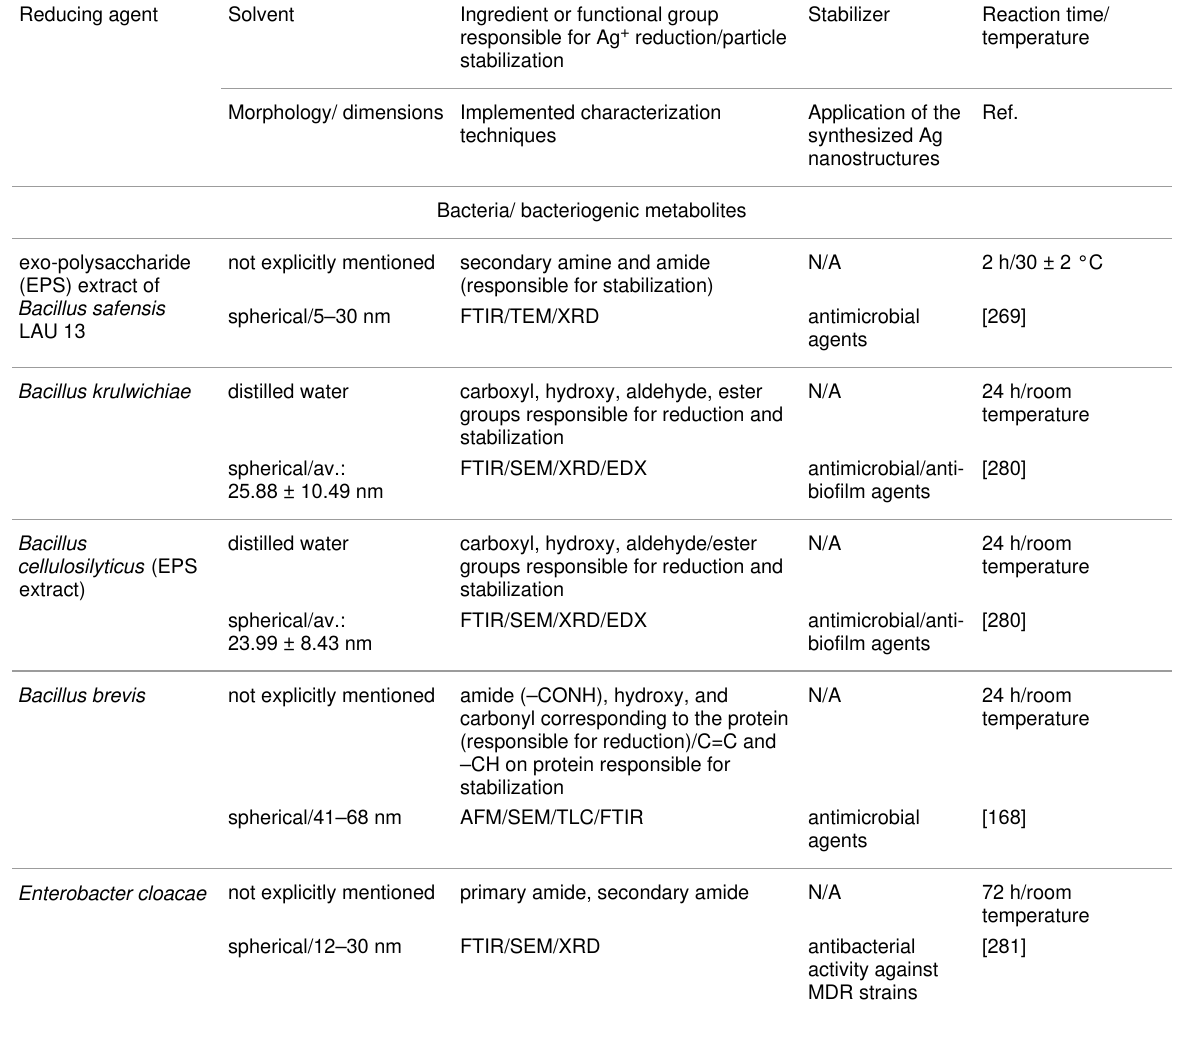
Table 2: A review of various green processes, reaction conditions, necessary functional groups, and characterization techniques used for the synthe- sis of silver nanostructures with different sizes and morphologies along with their application. Reducing